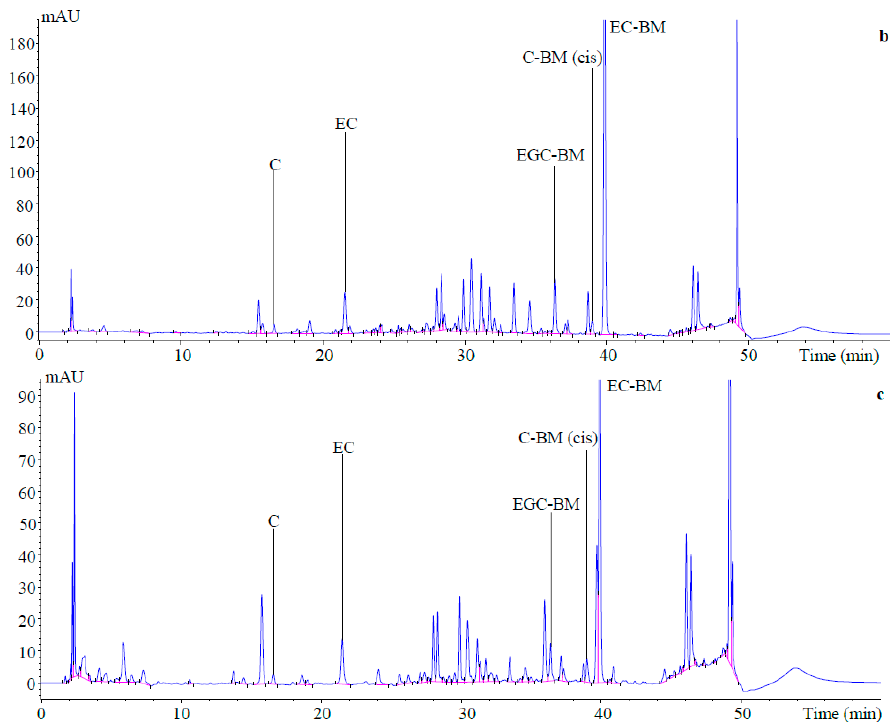
Figure 1. HPLC chromatograms (280 nm) of thiolysis reaction products that were obtained from ( a ) freeze-dried; ( b ) hay and ( c ) silage of whole-plant purple prairie clover. Terminal units: C = catechin, EC = epicatechin; Extension units as BM-adducts: EGC-BM = epigallocatechin, C-BM = catechin, EC-BM = epicatechin, where BM = benzyl mercaptan. Table 3. Structural composition of condensed tannins from whole-plant purple prairie clover conserved as freeze-dried forage (FD), hay (HAY) or silage (SIL). mDP 1 PC (%) 2 PD (%) Cis (%) 3 Trans (%) FD